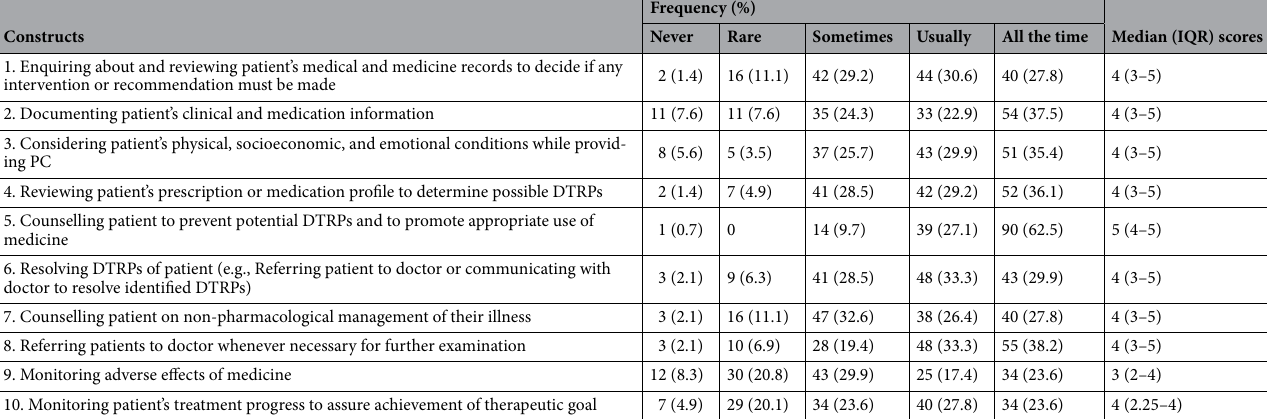
Table 5. Constructs related to the current practice of pharmaceutical care (n = 144). DTRPs drug therapy- related problems ( any unwanted incident related to medication therapy that actually or potentially affects the desired goals of treatment ), PC pharmaceutical care.